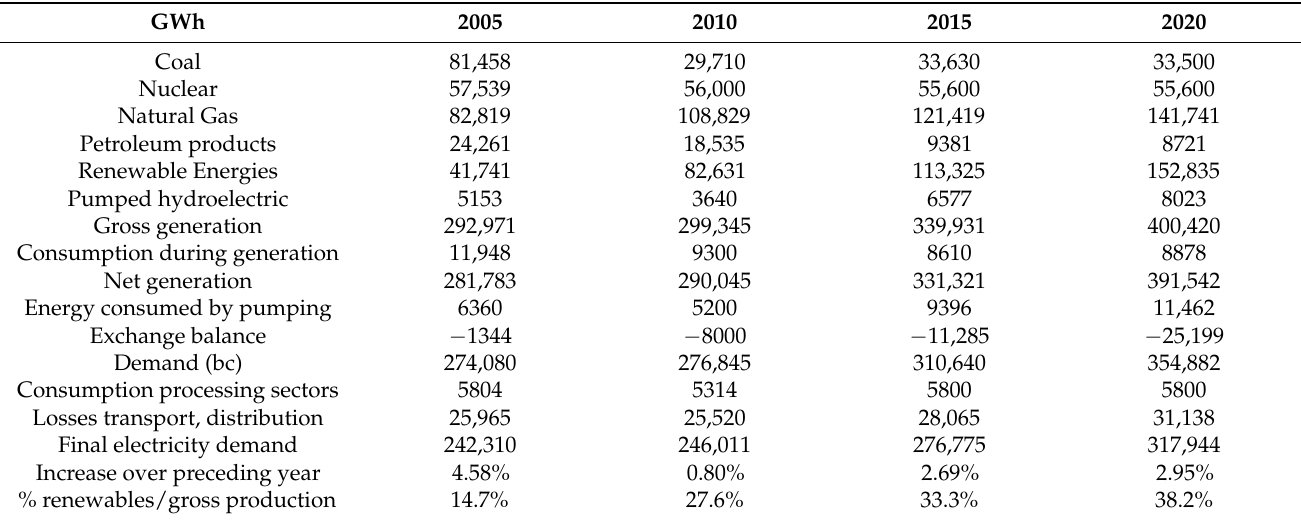
Table 2. National Electricity Balance of Spain